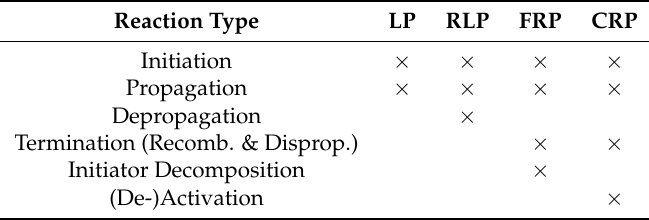
Table 1. Overview of the modeled reactions types for the living polymerization (LP), reversible living polymerization (RLP), free radical polymerization (FRP), and controlled radical polymerization